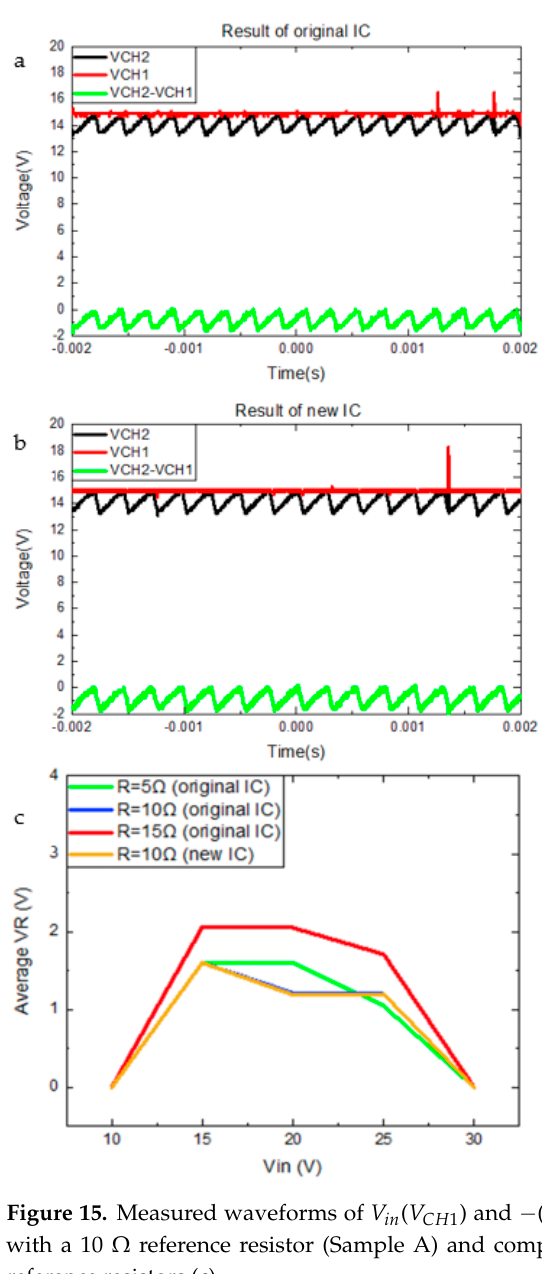
Figure 15. Measured waveforms of 𝑉 (cid:3036)(cid:3041) ( 𝑉 (cid:3004)(cid:3009)(cid:2869) ) and (cid:3398) ( 𝑉 (cid:3004)(cid:3009)(cid:2870) ‐ 𝑉 (cid:3004)(cid:3009)(cid:2869) ) of original ( a ) and new IC ( b ) with Figure 15. Measured waveforms of V in ( V CH 1 ) and − ( V CH 2 − V CH 1 ) of original ( a ) and new IC ( b ) a 10 Ω reference resistor (Sample A) and comparison of their output voltage for different reference with a 10 Ω reference resistor (Sample A) and comparison of their output voltage for different resistors ( c ). reference resistors ( c